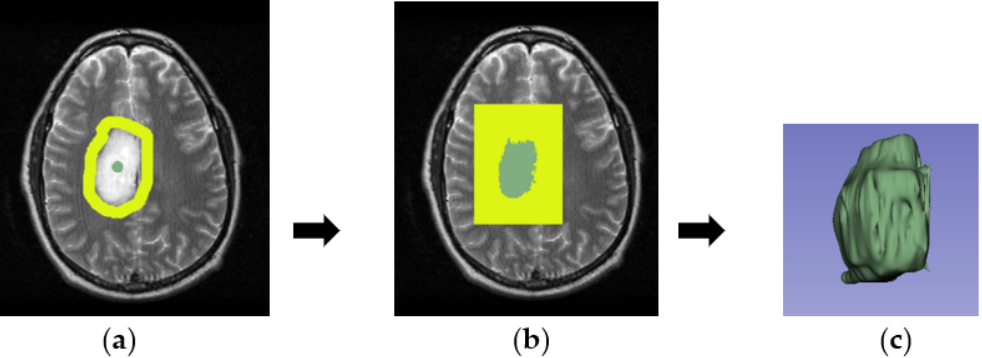
Figure 3. 3D tumor segmentation procedures for Grade II brain tumor in 3D Slicer with the ROI identified ( a ), application of GrowCut ( b ), and 3D visualization of the tumor ( c ).